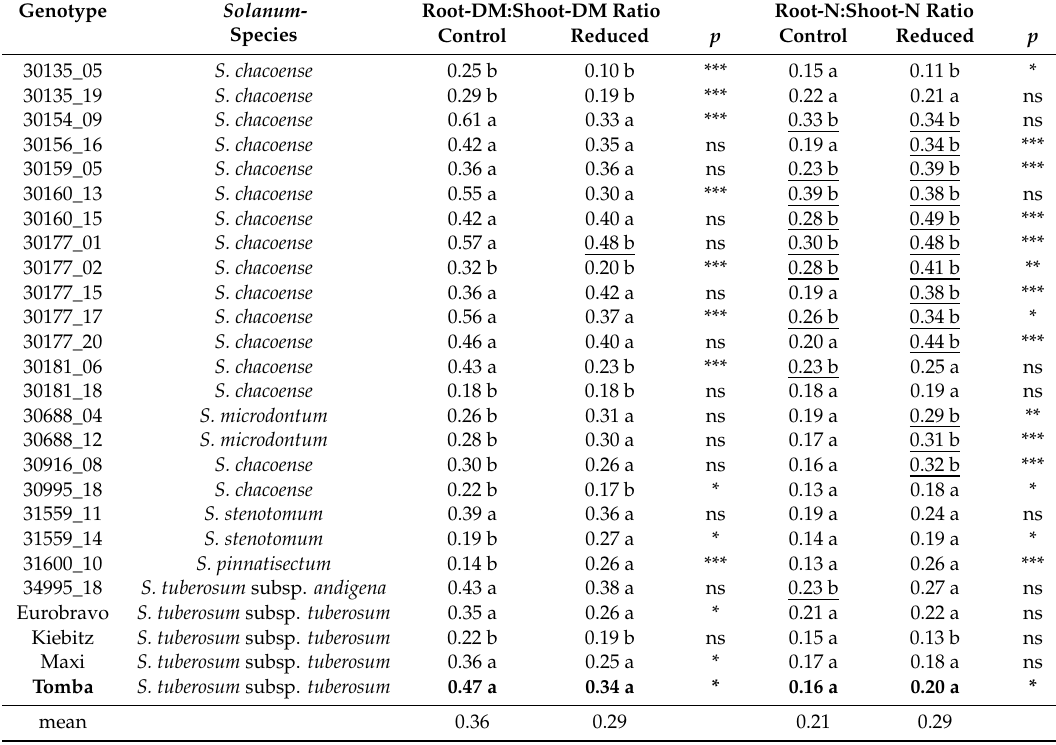
Table 5. Mean root-DM:shoot-DM ratio as well as partitioning of N taken up by the di ff erent wild potato genotypes (root-N:shoot-N ratio) cultivated under optimal and reduced N conditions in a climate chamber for 21 days. Results of ANOVA and post hoc comparison of